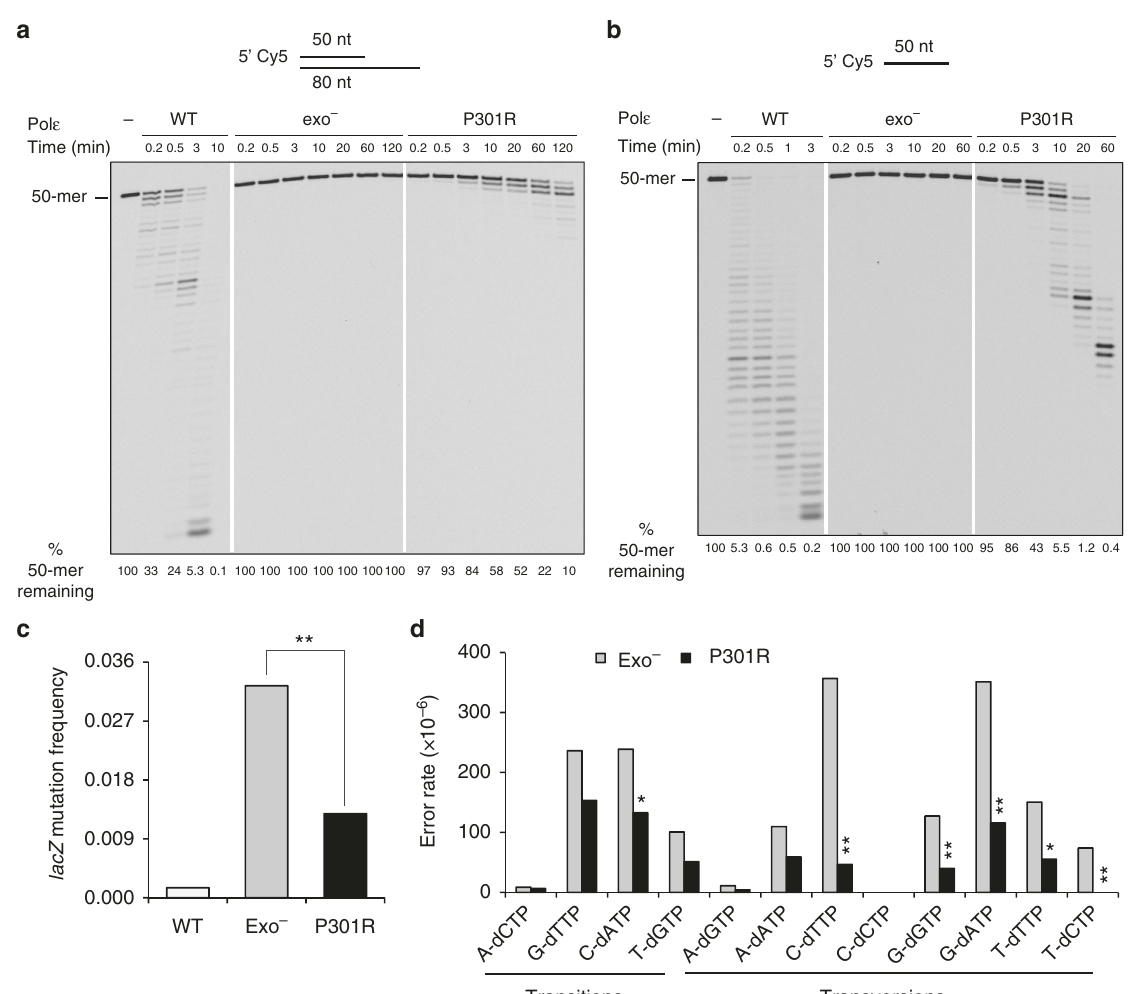
Fig. 1 Pol ε -P301R retains weak 3 ʹ → 5 ʹ exonuclease activity and is more accurate than the proofreading-de fi cient Pol ε . a Exonuclease activity of wild-type Pol ε (WT), exo − Pol ε and Pol ε -P301R was assayed with 25 nM P50/T80 oligonucleotide substrate and 6.25 nM polymerase. Representative of >10 independent experiments. b Exonuclease activity of the Pol ε variants was assayed with 25 nM P50 single-stranded oligonucleotide and 4 nM polymerase. Representative of six independent experiments. c lacZ mutation frequencies resulting from in vitro DNA synthesis by wild-type Pol ε , exo − Pol ε and Pol ε - P301R. d In vitro error rates for the 12 possible base-base mispairs generated by exo − Pol ε and Pol ε -P301R. Source data for a and b are provided in a Source Data fi le. Data for c and d are from Supplementary Table 1. Asterisks indicate statistically signi fi cant differences between exo − Pol ε and Pol ε -P301R: * p < 0.05; ** p < 0.01 (Fisher ’ s exact synthesis. Tetrad dissection of heterozygous POL2/pol2-P301R MSH6/msh6 Δ diploids showed that the combination of the P301R substitution with the MMR defect results in synthetic lethality (Fig. 2b, left). The double mutant pol2-P301R msh6 Δ cells were able to divide and form microcolonies of varying size before cell division stopped (Fig. 2b, right), a phenotype indicative of replication error catastrophe 3 . In contrast, double pol2-4 msh6 Δ mutants carrying exo − Pol ε and lacking the Msh6-dependent MMR were readily produced by sporulation of POL2/pol2-4 MSH6/msh6 Δ diploids (Fig. 2b, middle). The synthetic lethality of pol2-P301R and msh6 Δ demonstrates that the pol2-P301R strains accumulate an enormous amount of DNA replication errors, which, in the absence of MMR, exceed the viability threshold.